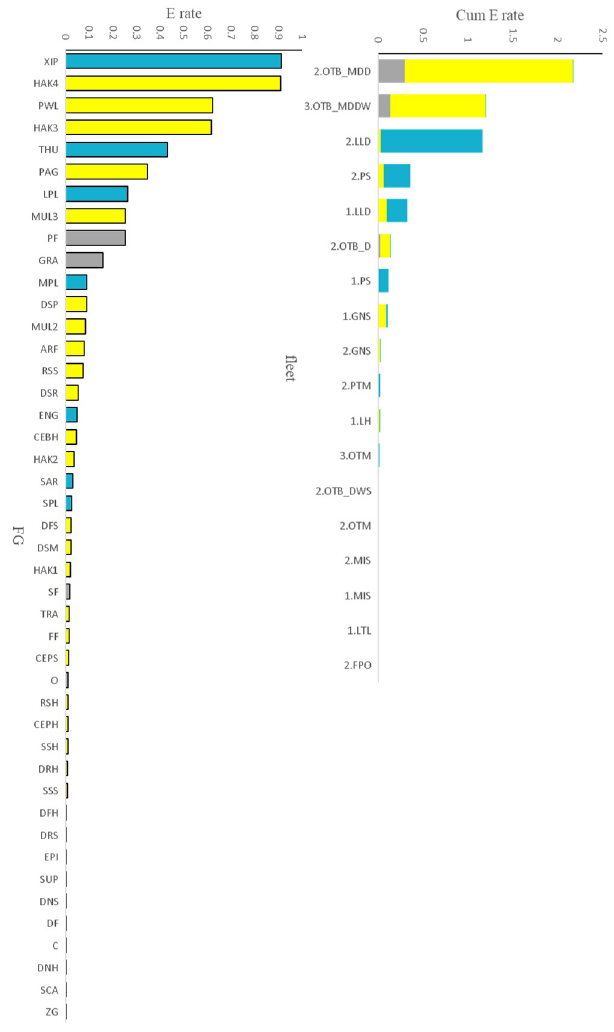
Fig 5. Direct effects of fishing on the 3 domains: Exploitation rate (E) by FGs (left) and cumulative exploitation rate (Cum E) by fleet (right). FGs belonging to pelagic (cyan), demersal (yellow) and benthic (gray) domain. Details of fleets and FGs in Tables